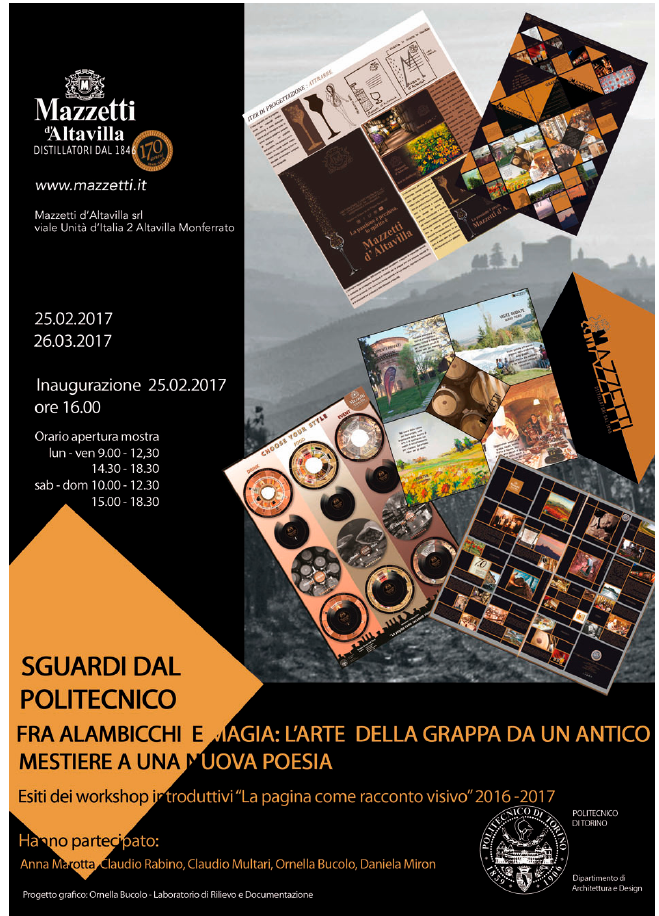
Figure 6. Flyer for the presentation of the event at Distilleria Mazzetti d’Altavilla in Monferrato. On the background, there are the soft hills characterizing the area around the distillery and on the foreground the promotional products produced. The predominant chromium refers to the color of grappa and its